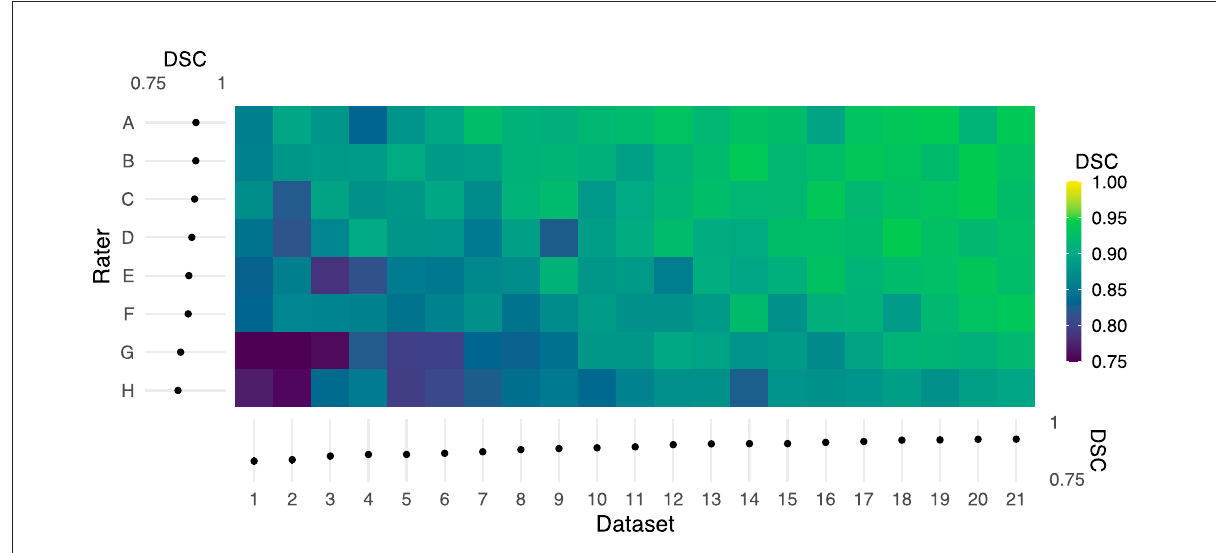
FIGURE2 Color map of Dice similarity coefficients (DSC) comparing each rater mask with the reference mask for each of 21 datasets. Both the rater and dataset axes are organized from lowest to highest average logit-transformed DSC. The margins (left and bottom) contain estimated marginal means for each rater and dataset, and error bars indicate 95% CIs. Horizontal and vertical gradient trends indicate the effect of rater and dataset, respectively, on agreement with the reference.